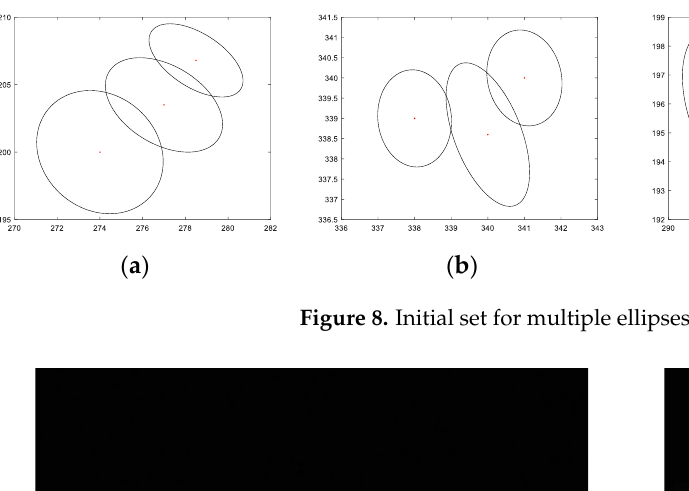
the third target. The purple line denotes the trajectory of the fourth target.